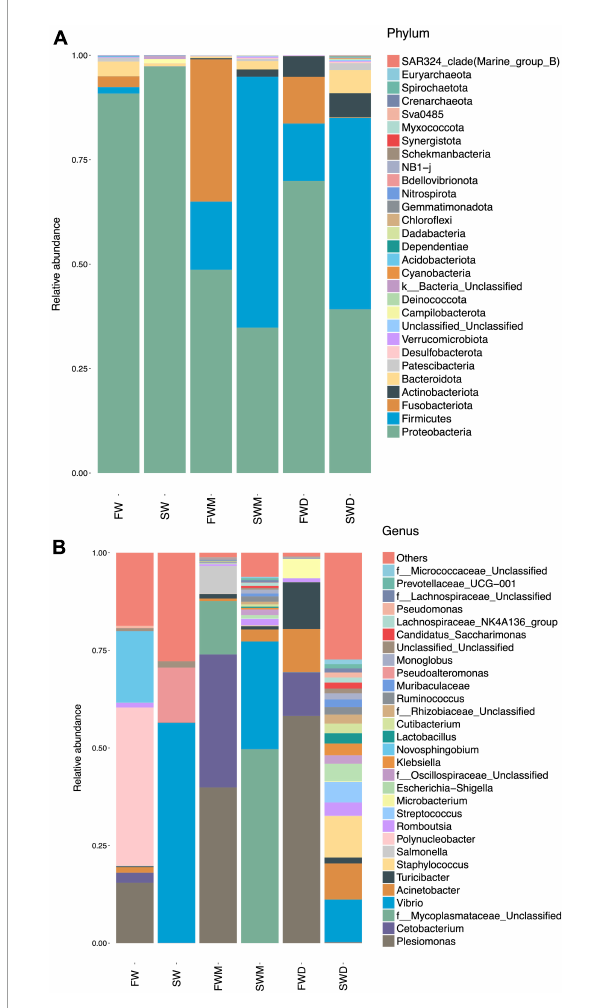
FIGURE3 Relative abundance of major taxonomic lineages at the (A) phylum and (B) genus levels. SW, seawater; FW, freshwater;